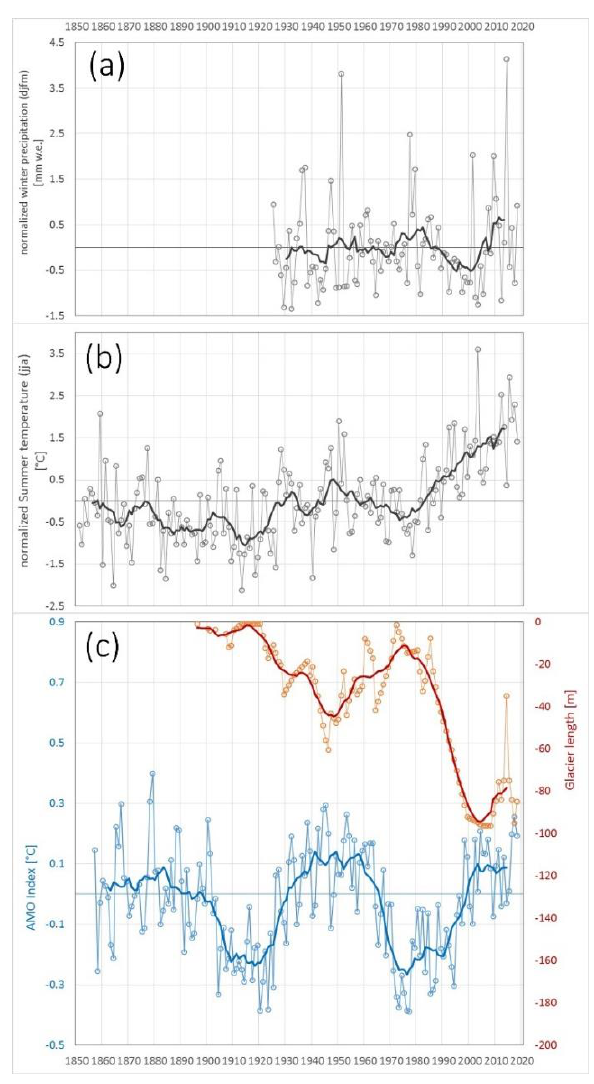
Figure 9. ( a ) Winter (DJFM) precipitation [28]; ( b ) summer (JJA) temperature [28]; ( c ) AMO index and observed length change of Canin East glacier (https://www.esrl.noaa.gov/psd/data/timeseries/AMO; Last accessed 5 August 2020). Bold lines indicate a 11-year low-pass filter, Red line in ( c ) refers to glacier length while blue line to AMO